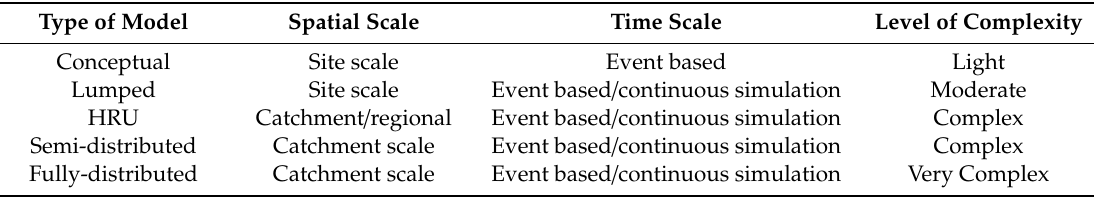
Table 1. Proposed scaling for assessing urban hydrologic models’ level of complexity.